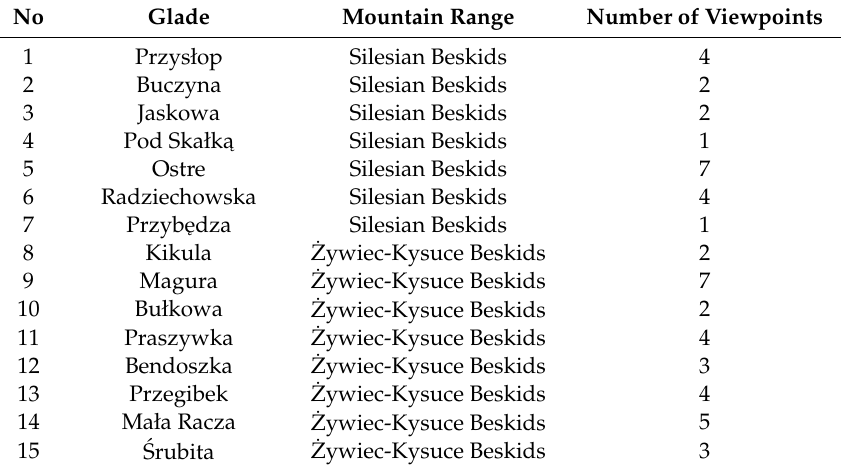
Table 1. Location of